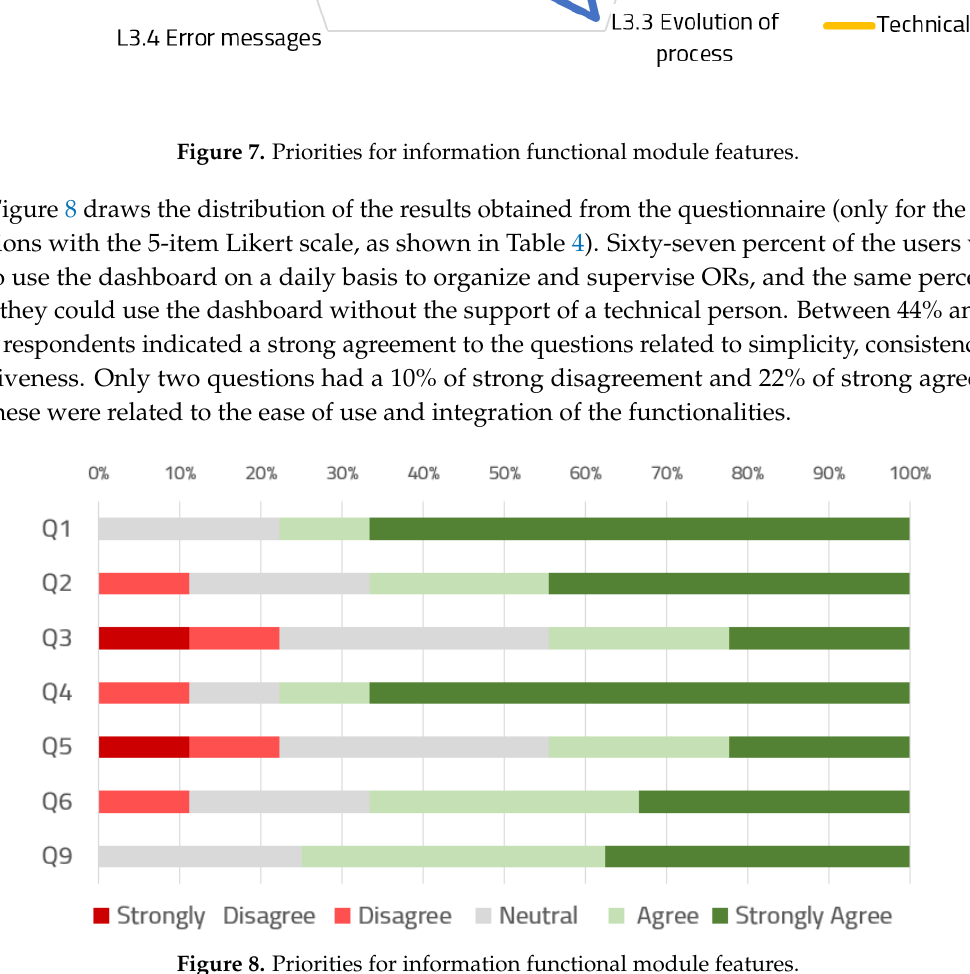
Figure 8. Priorities for information functional module